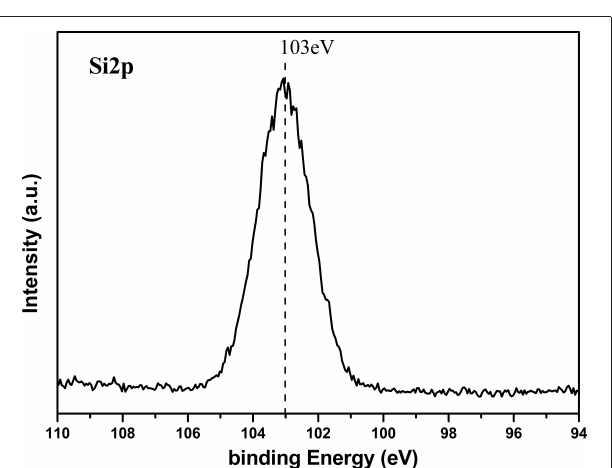
FIGURE 5 | Si2p XPS signal of SiO 2 shell on ZnO nanorod arrays.